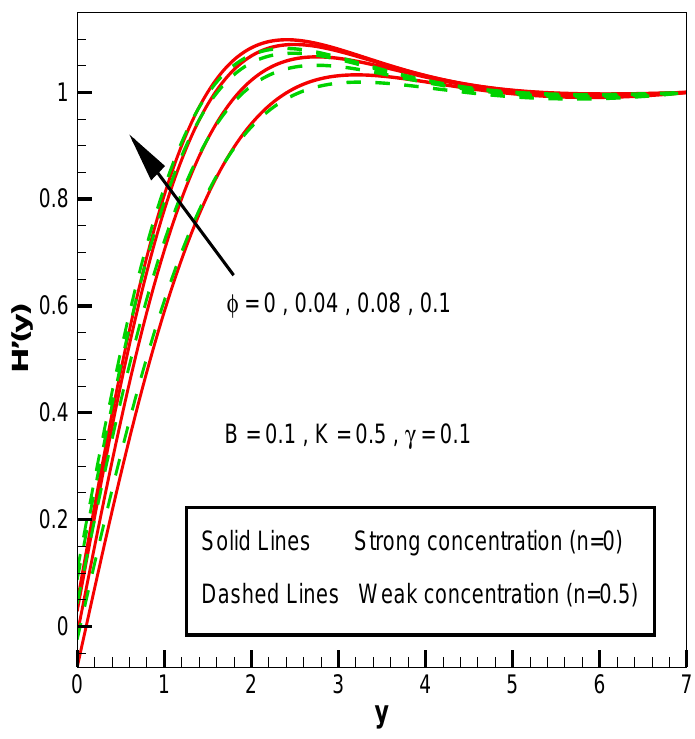
Figure 5. H (cid:48) ( y ) for volume fraction of nanoparticles φ . Figure 5. 𝐇′(𝐲) for volume fraction of nanoparticles 𝛟 .